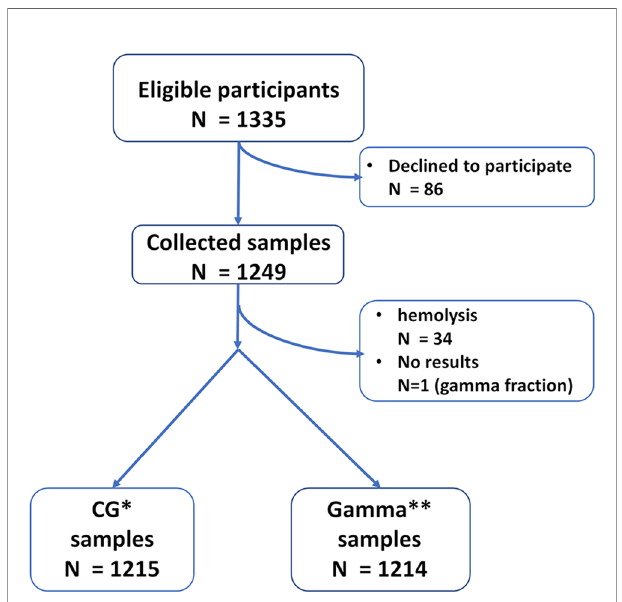
FIGURE 1 | Sample fl ow. *CG – Calculated Globulin. **Gamma – Gamma Globulin